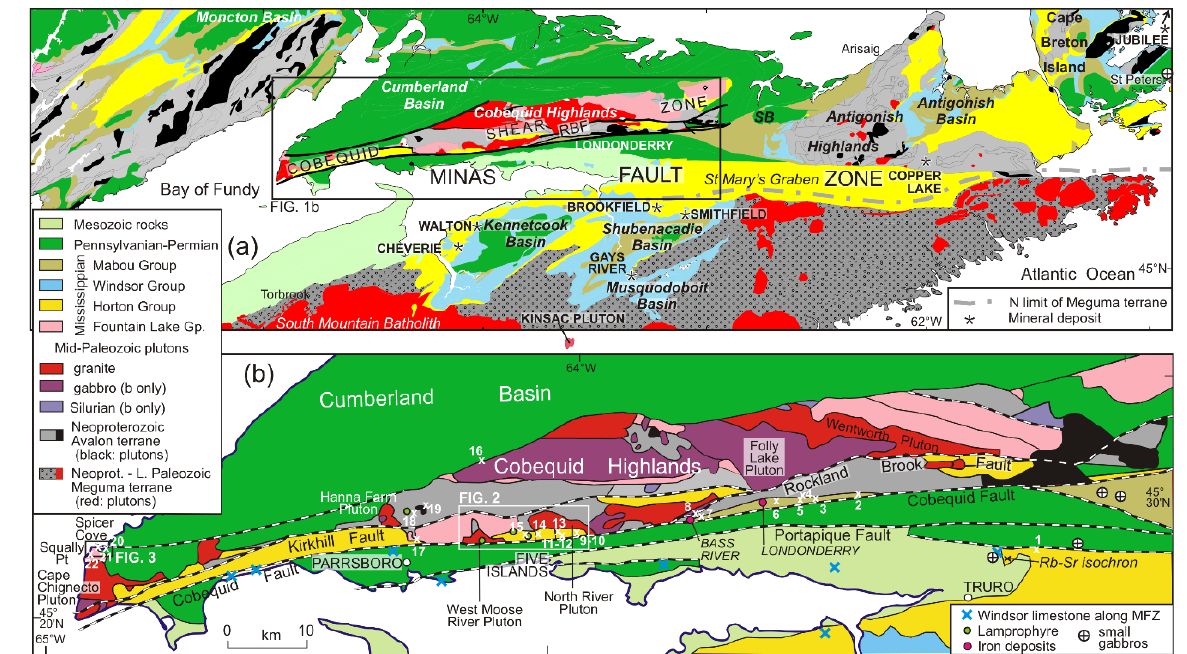
Figure 1. ( a ) Geological map of the Minas Fault Zone in northern Nova Scotia (modified from [4]) and ( b ) more detailed map of the Cobequid Highlands showing location of barite mineralization (numbers refer to Table 1; modified from [6]).